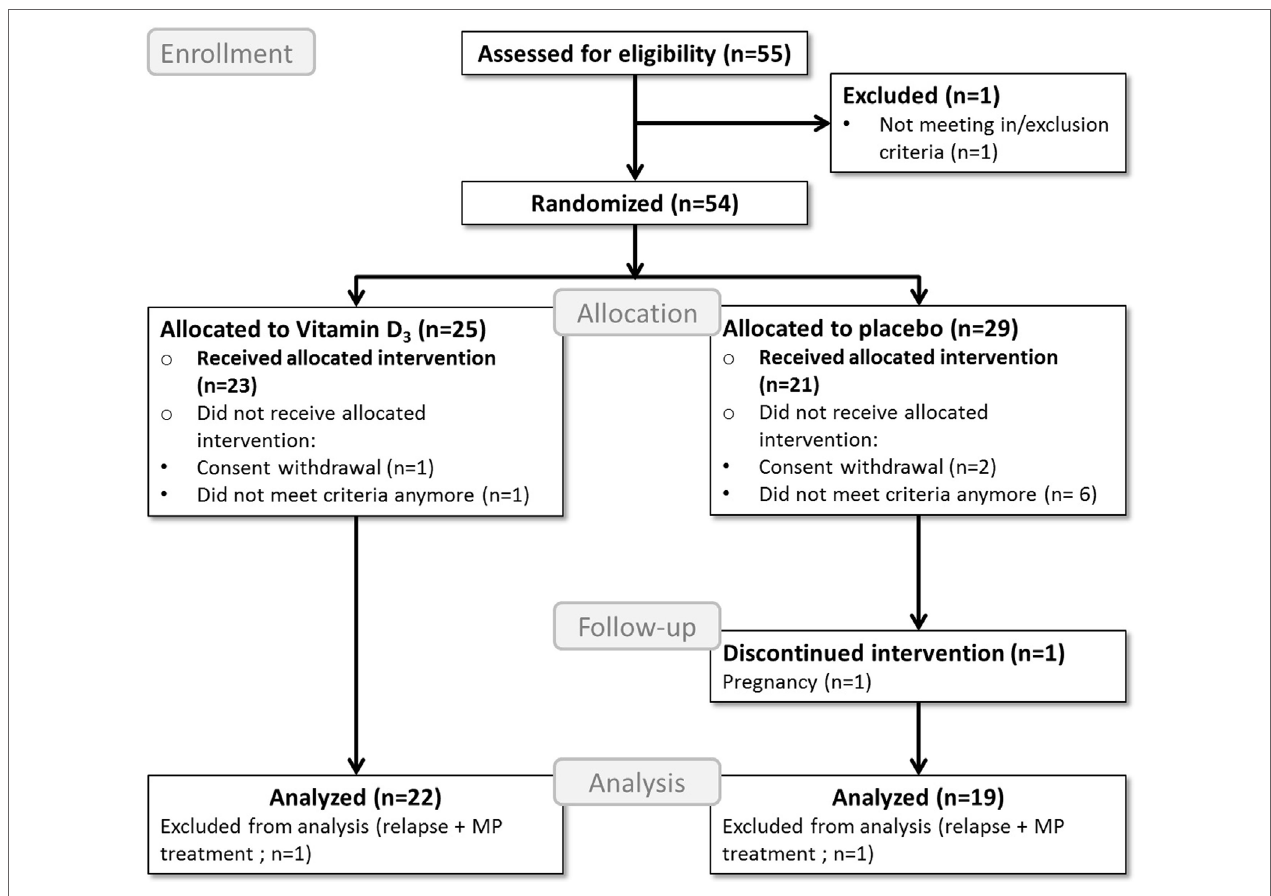
FigUre 1 | Flow diagram of the study process. MP, methylprednisolone; Analyzed = included in the primary endpoint analysis; Received allocated intervention = included in the safety